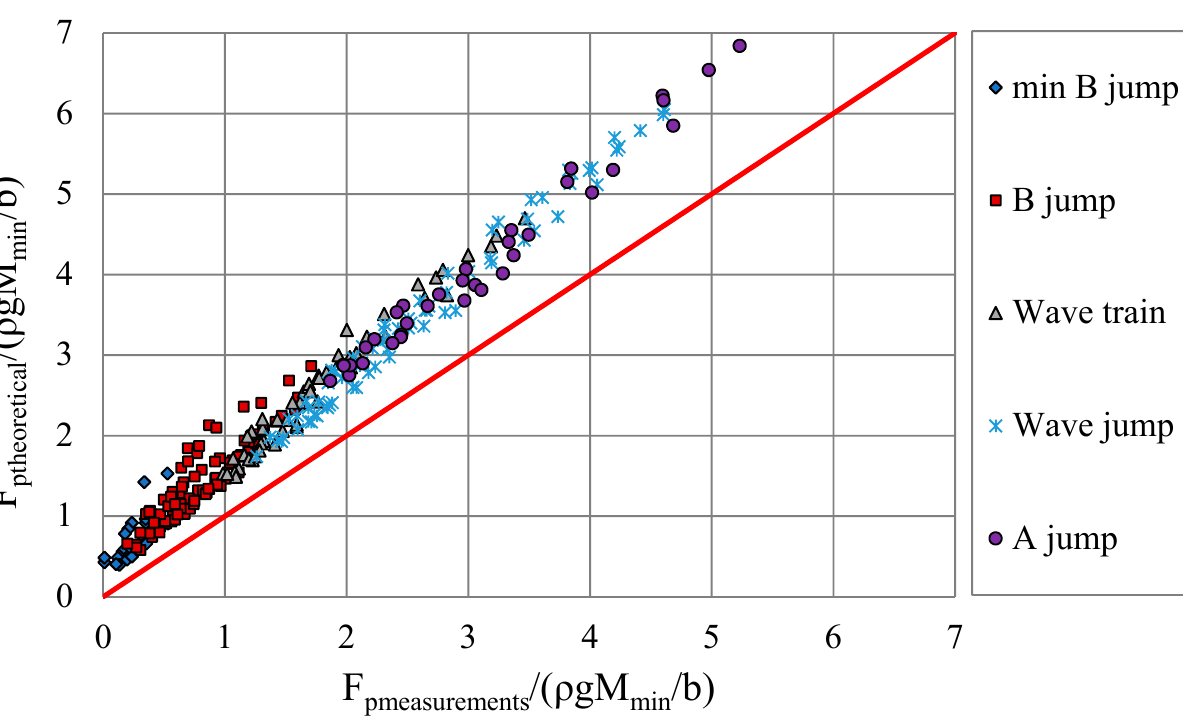
Figure 12. Comparison between the theoretical and the experimental results for the non-dimensionless pressure force at the face of the step for all types of jumps.